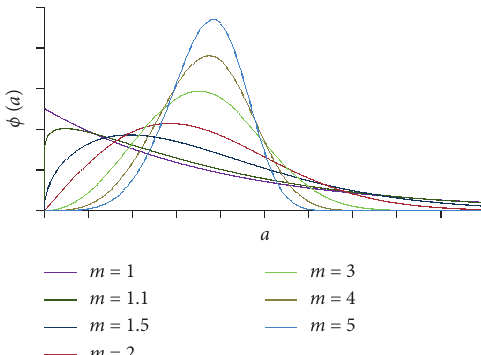
Figure 3: Weibull’s distribution of the mechanical parameters of materials with different heterogeneity m value